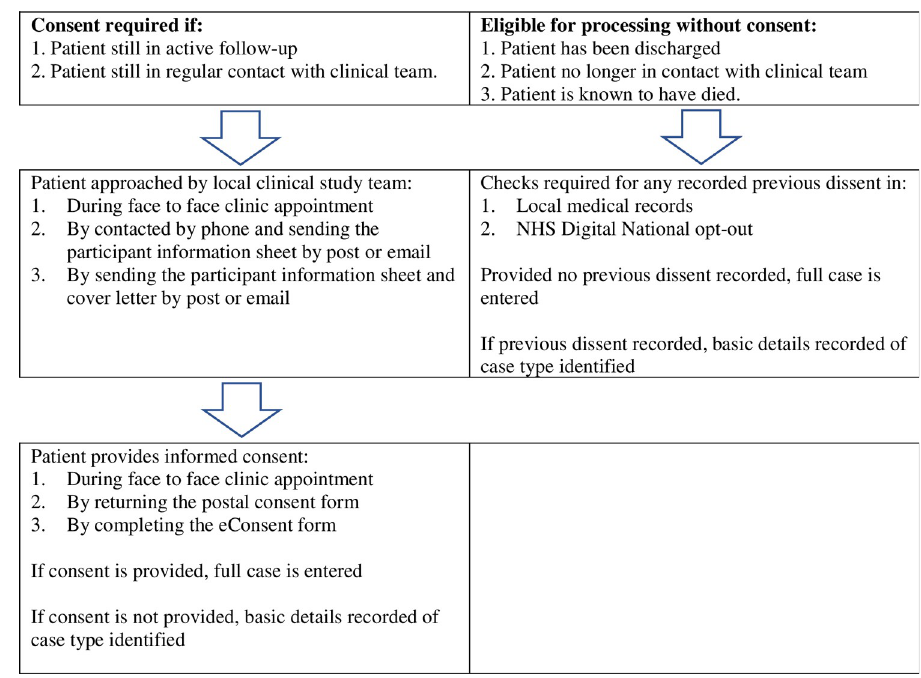
Fig 1. Procedure for processing cases with and without consent.